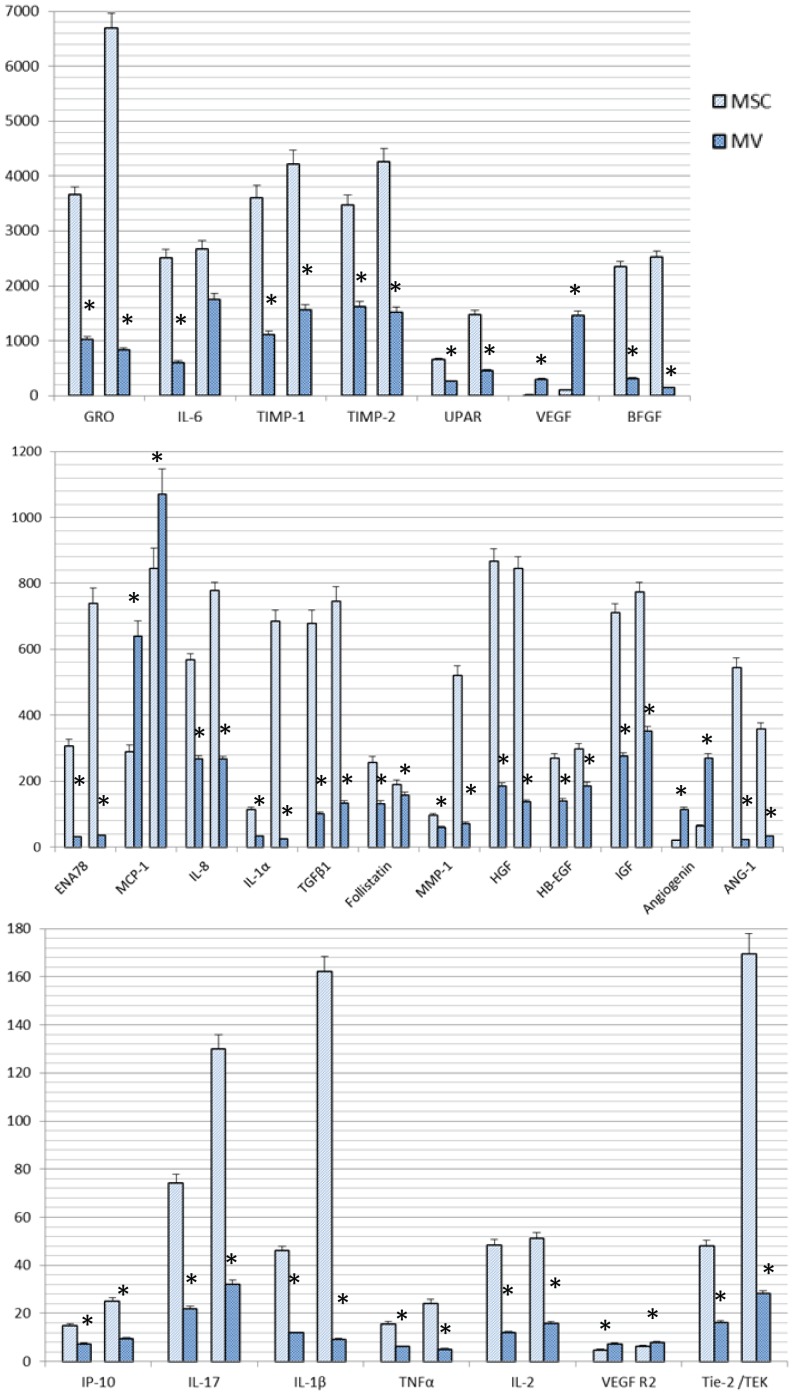
Comparison of cytokine concentrations (pg/ml) in MVs and parent MSCs detected by antibody array.A represents normoxic condition and B represents hypoxic condition. Results are expressed as mean ± SD. *, P<0.05.